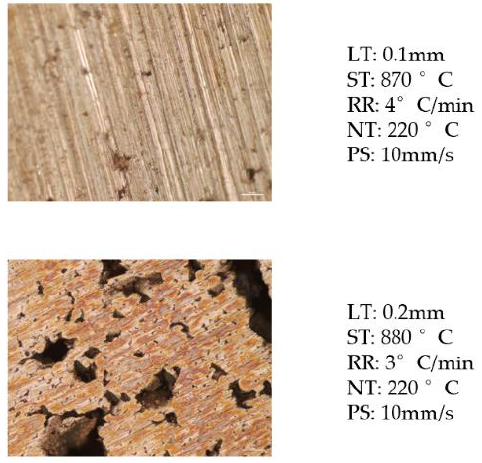
Figure 9. Interactions of manufacturing parameters.